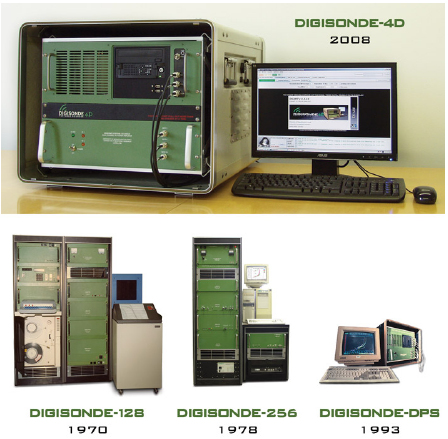
Figure 3. Evolution of digisonde sounders since